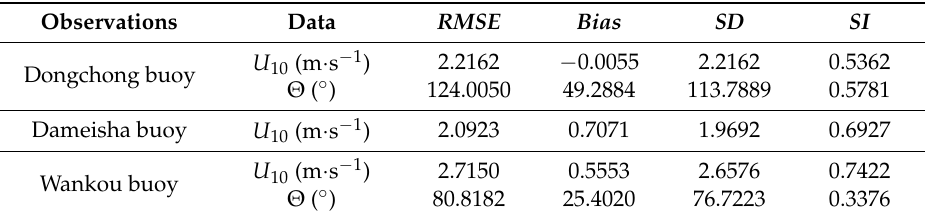
Table 5. Summary of the error indicators for the Typhoon Matmo simulation.